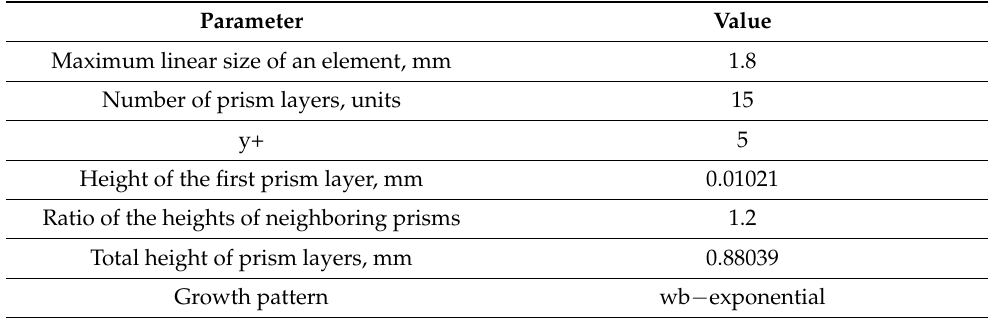
Table 1. Computational grid parameters for the flow volume.